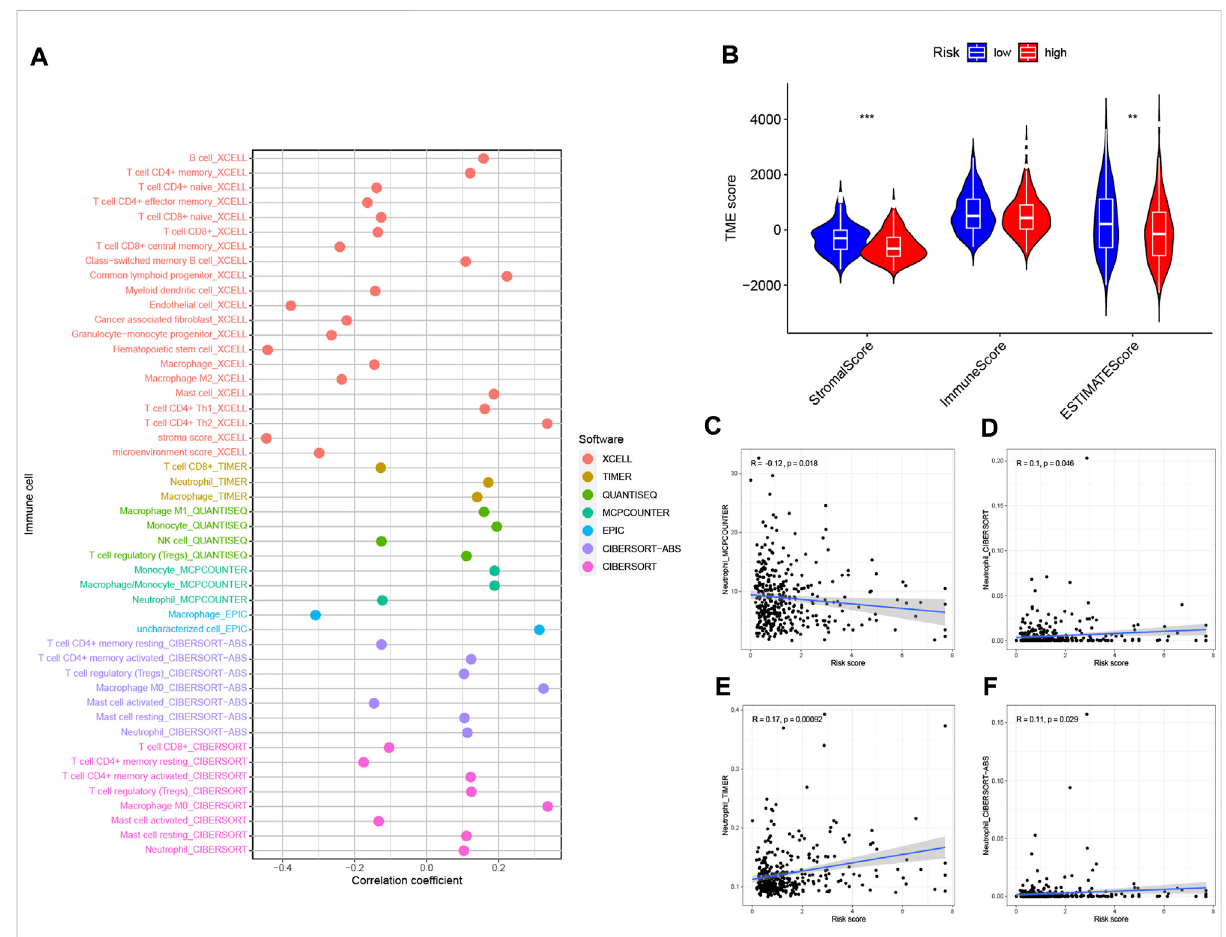
FIGURE 10 Estimated abundance of tumor-in fi ltrating cells. Patients in the (A) high-risk group had a stronger correlation with tumor-in fi ltrating immune cells, as shown bythe Spearman correlation analysis. (B) Association between prognostic risk signatures and central immune checkpoint genes.